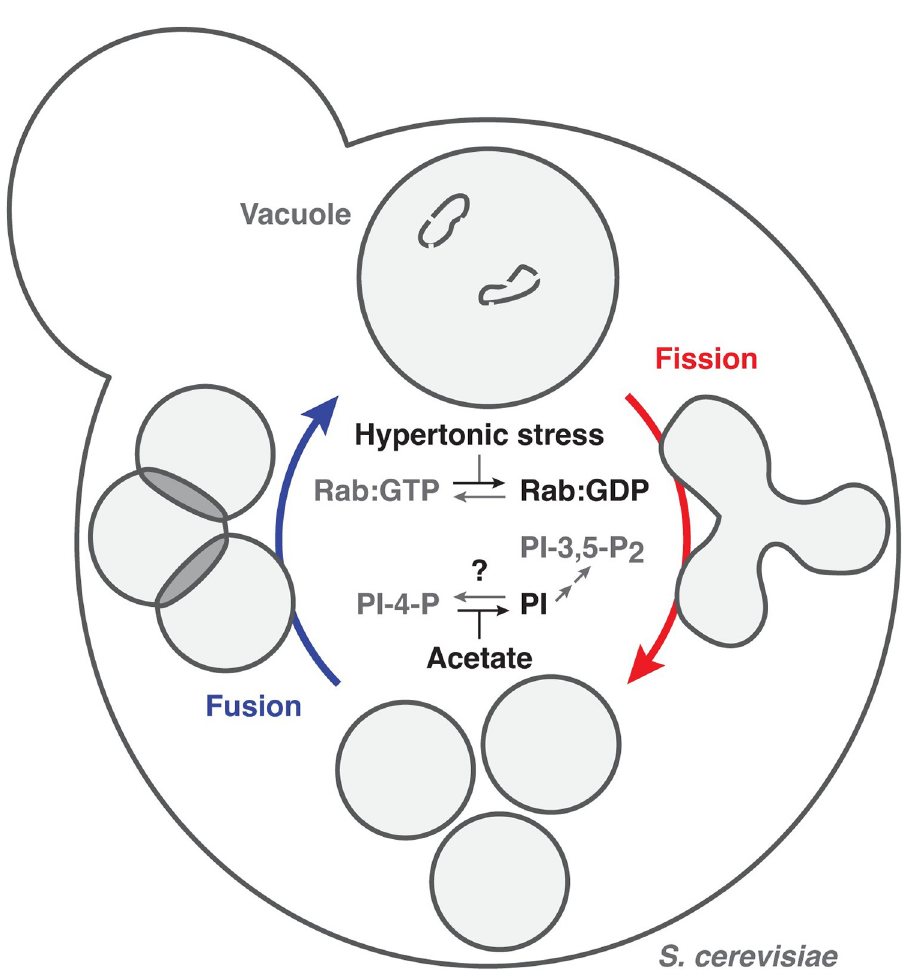
Fig 1. Working model of vacuole morphology affected by metabolic or osmotic stress. Illustration depicting molecular potential interactions between Rab-GTPase and phosphatidylinositol signaling underlying vacuole fission and fusion triggered by acetate or hypertonic stress. Acetate likely inhibits a PI4-kinase whereas hypertonic stress targets Rab-GTPase inactivation to promote vacuole fission over fusion.